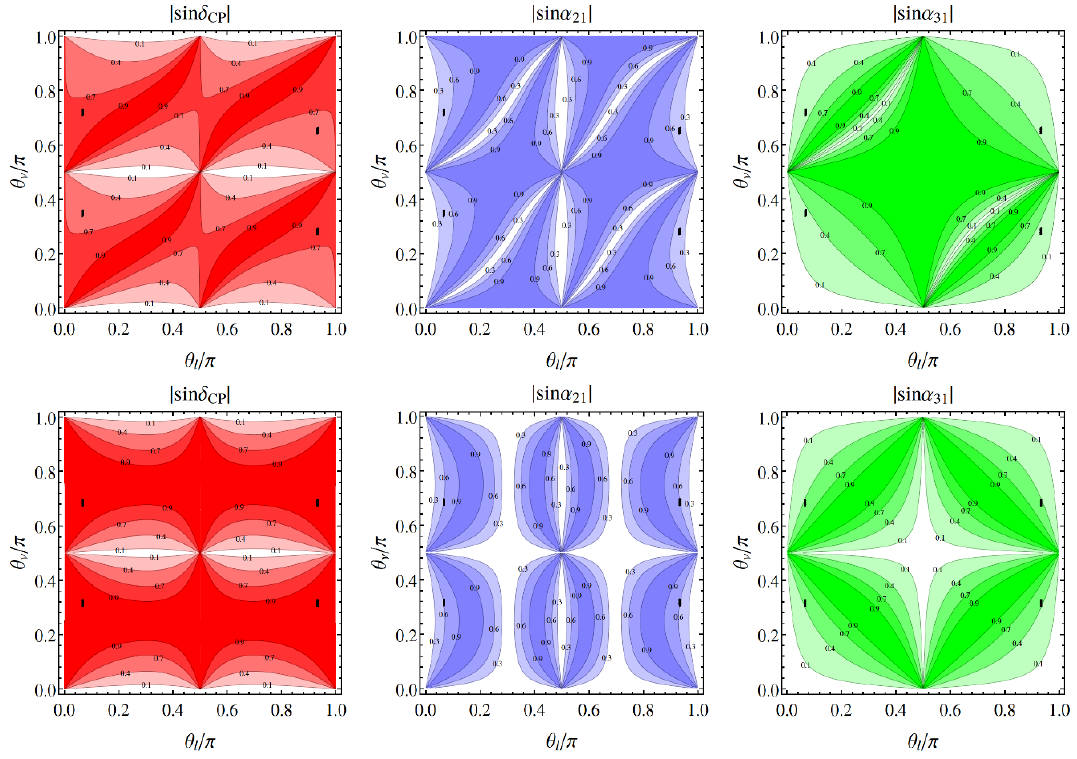
Figure 2 . The contour plots of the CP violation phases j sin (cid:14) CP j , j sin (cid:11) 21 j and j sin (cid:11) 31 j for the mixing pattern U I ; 6 , where the parameters ( ’ 1 ; ’ 2 ) are equal to ( (cid:25)= 4 ; (cid:25)= 4) in the upper panels and ( (cid:25)= 4 ; (cid:25)= 2) in the lower panels. The black areas represent the regions for which all the three lepton mixing angles lie in their corresponding experimentally allowed 3 (cid:27) intervals [8]. As U I ; 6 and U I ; 9 are related through the exchange of the second and the third rows of the mixing matrix, they lead to the same Majorana phases (cid:11) 21 and (cid:11) 31 while the Dirac phase changes from (cid:14) CP to (cid:25) + (cid:14) CP